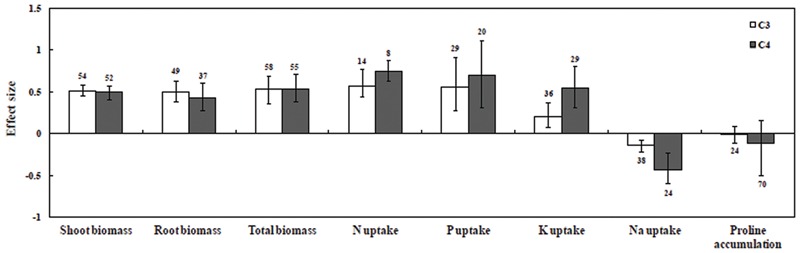
Comparative photosynthetic growth and nutrient uptake responses of arbuscular mycorrhizal fungi (AMF)-inoculated plants under salt stress. Error bars are means ± bias CIs. Where the CIs do not overlap the horizontal dashed lines, the effect size for a parameter is significant at P < 0.05. A number of studies were included for the meta-analysis mentioned above the bar.